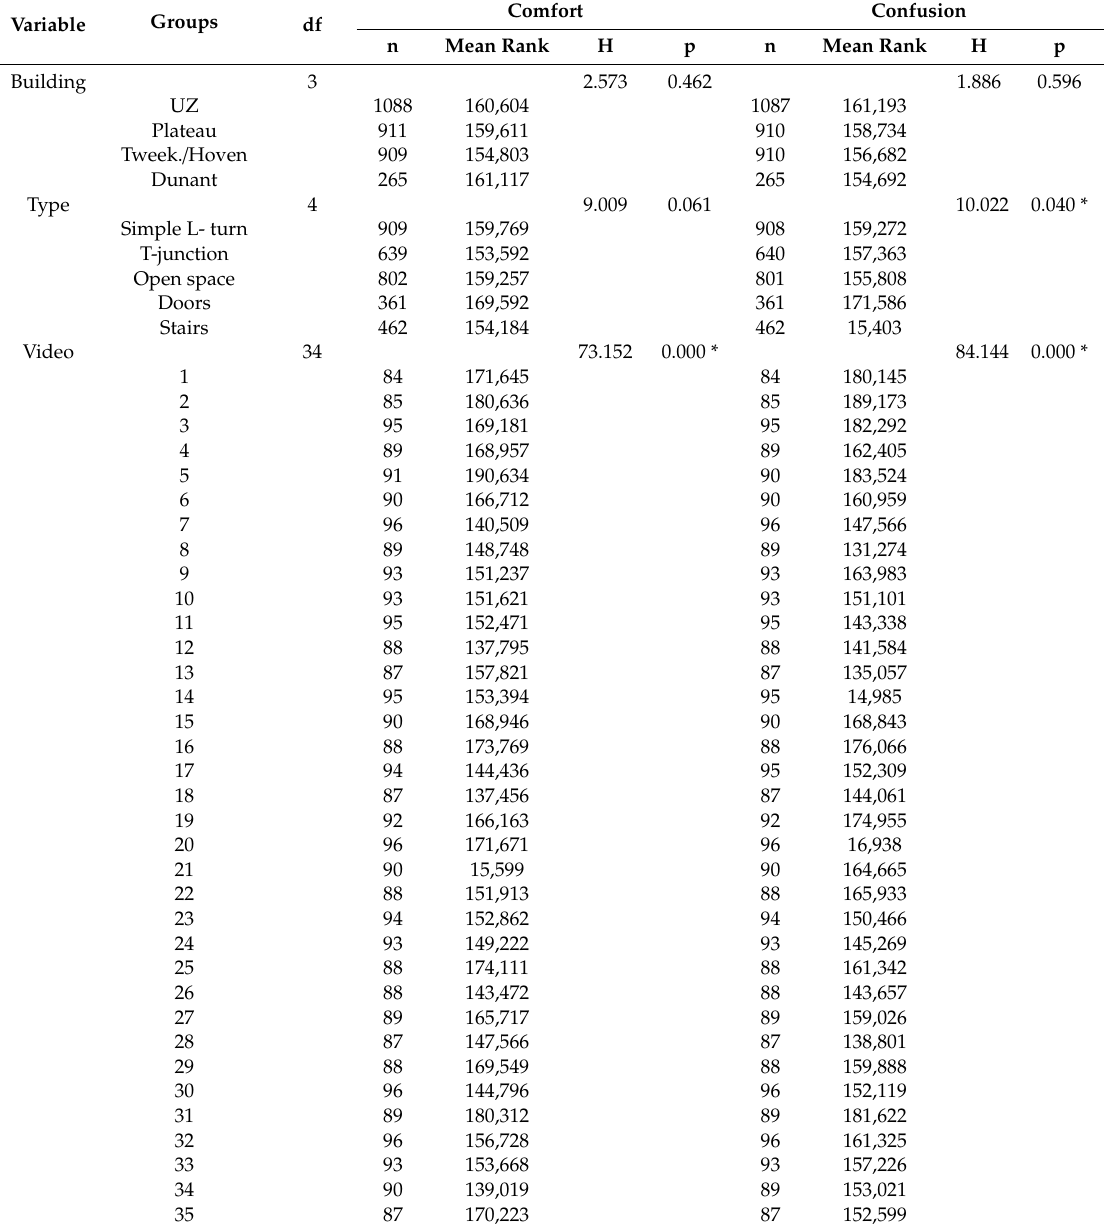
Table 5. Results of the Kruskal-Wallis